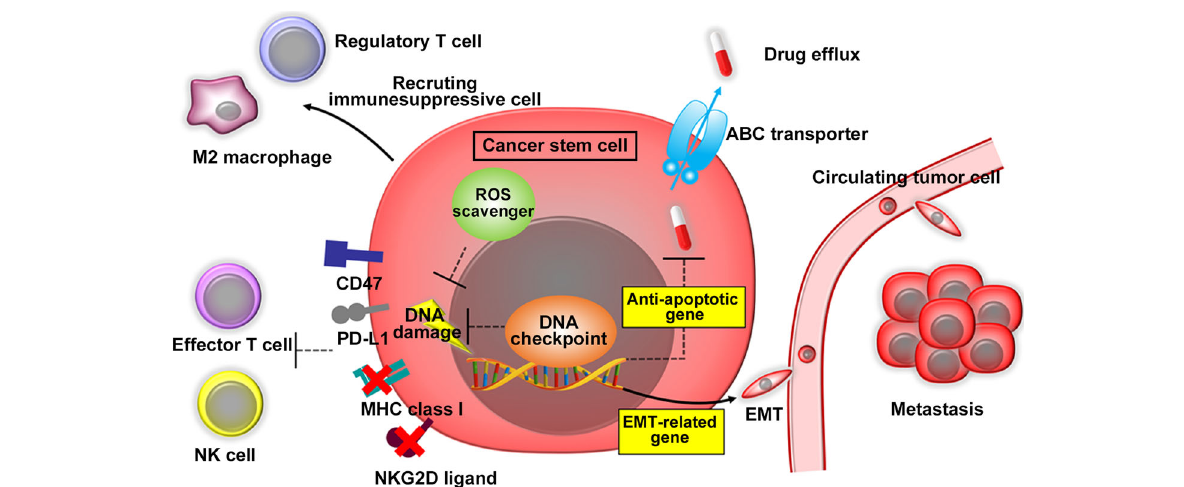
Fig. 3 Presumed biological properties of CSCs. CSCs are in a dormant state and therefore, are resistance to chemotherapy and irradiation, which are mainly effective against proliferating cells. Moreover, CSCs exhibit enhanced expression of ABC transporters and anti-apoptotic molecules, efficiently expel chemotherapeutic drugs and to counteract drug-induced apoptosis, respectively. Furthermore, CSCs display higher levels of reactive oxygen species (ROS) scavengers and augmented DNA checkpoint activation, to counteract ROS-induced adverse effects and to prevent DNA damages, respectively. CSCs dampen tumor immunity by inhibiting effector T cell and inducing immunosuppressive M2-macrophages and regulatory T cells (Tregs). Moreover, CSCs exhibit enhanced expression of immune checkpoint molecules to hamper T cell-mediated tumor immunity. CSCs further express reduced expression of HLA class I antigen and KKG2D ligand to escape cytotoxicity mediated by effector T cells and natural killer (NK) cells, respectively. Furthermore, CSCs display EMT phenotypes, which are indispensable for metastasis